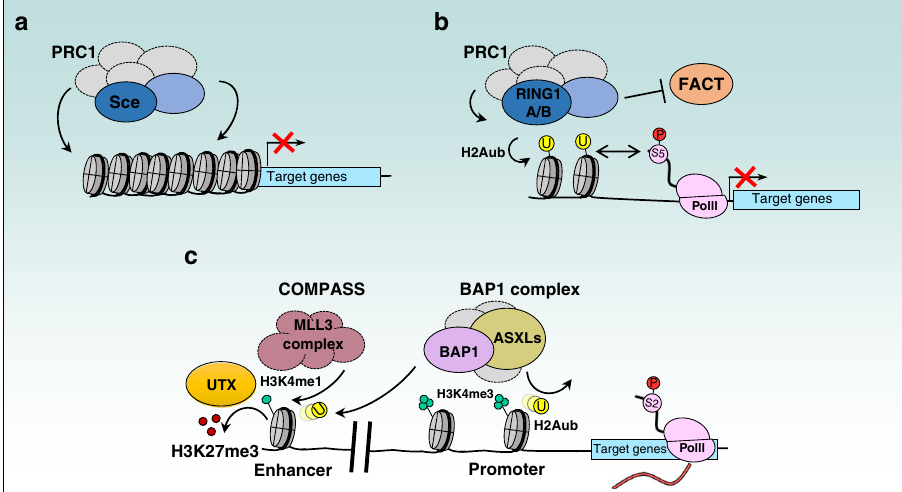
Fig. 5 Regulation of gene transcription by H2Aub ubiquitination and deubiquitination. a Recruitment of PRC1 complexes to compact chromatin regions in H2Aub-independent manner. These chromatin domains become inaccessible to the transcriptional machinery and are thus repressed. b H2A ubiquitination could contribute to gene repression by blocking the FACT histone chaperone. This would block nucleosome rearrangement resulting in maintenance of poised RNA PolII at promoters and inhibition of transcription elongation of speci fi c target genes. Poised PolII is phosphorylated on serine 5. c BAP1 DUB complexes act at enhancers to recruit MLL3 and UTX to deposit H3K4me1 and demethylate H3K27me3, respectively. These events along with deubiquitination of H2Aub promote gene activation. Ubiquitination is shown in yellow circle, H3K27me3 is shown by the three red circles, H3K4me1/3 is shown by green circles and phosphorylation by bigger red